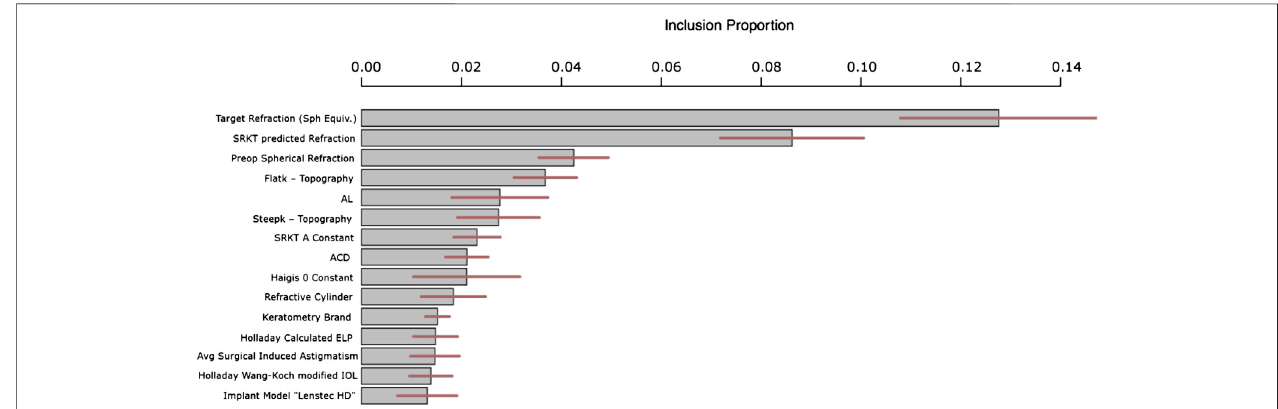
FIGURE 4 | Top 15 most important variables for prediction ranked by inclusion proportion in the BART model. The remaining variables have similar inclusion proportions to the least important shown below i.e., approximately 1%. The lines through each bar shows 95% con fi dence across the BART model ’ s Monte Carlo